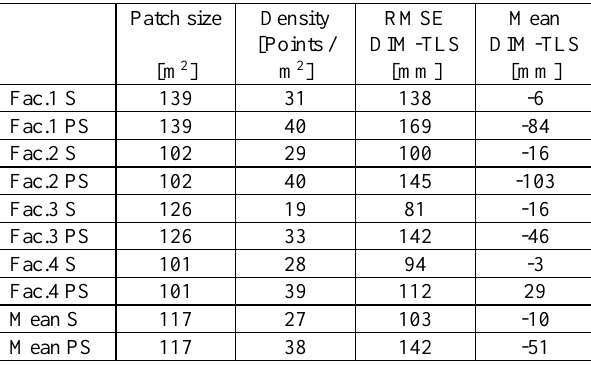
Table 1. Density and deviation values for all administration